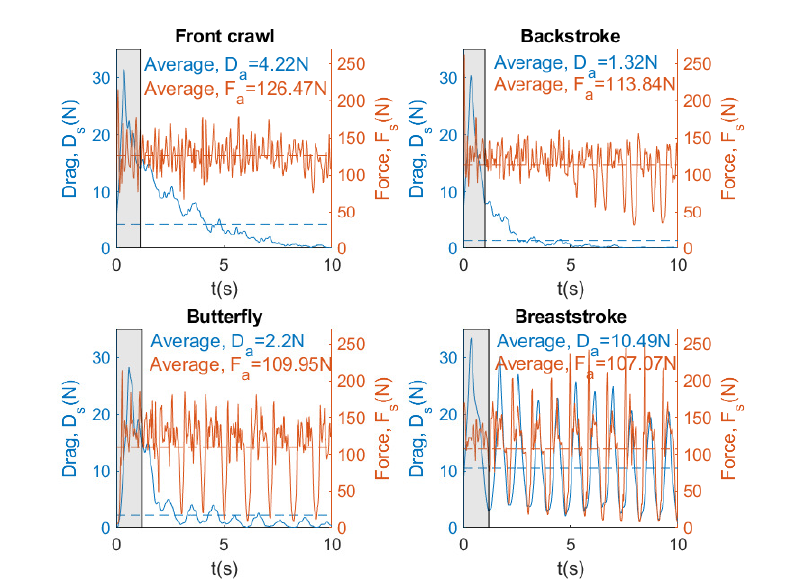
Figure 21. Instantaneous and average force and drag for four swimming strokes. Brake force = 152.96